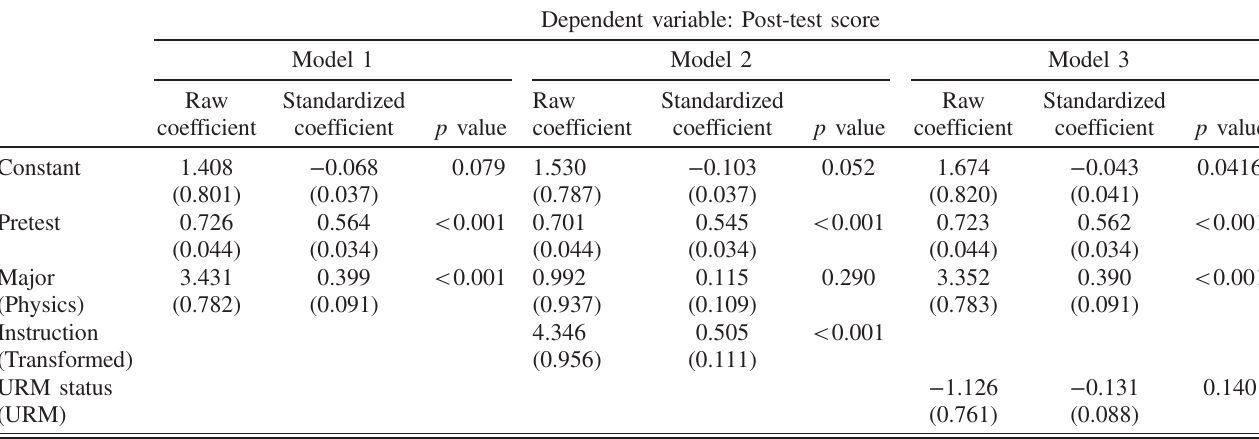
TABLE I. Results of fitted linear regressions for three illustrative examples using the E-CLASS. Models were built to explicitly illustrate omitted variable bias and are not based on any causal theory. Standardized coefficients are reported with pre- and post-test scores grand mean